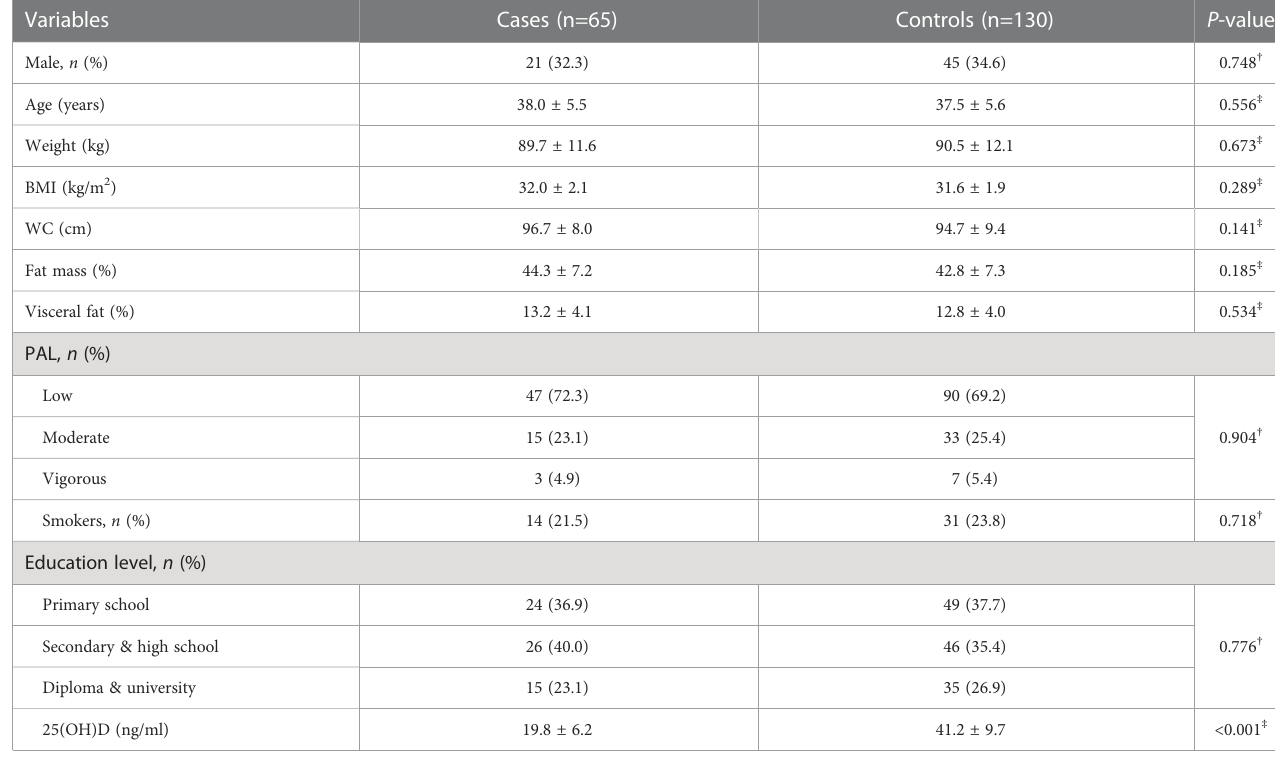
TABLE 1 General characteristics of cases and controls.